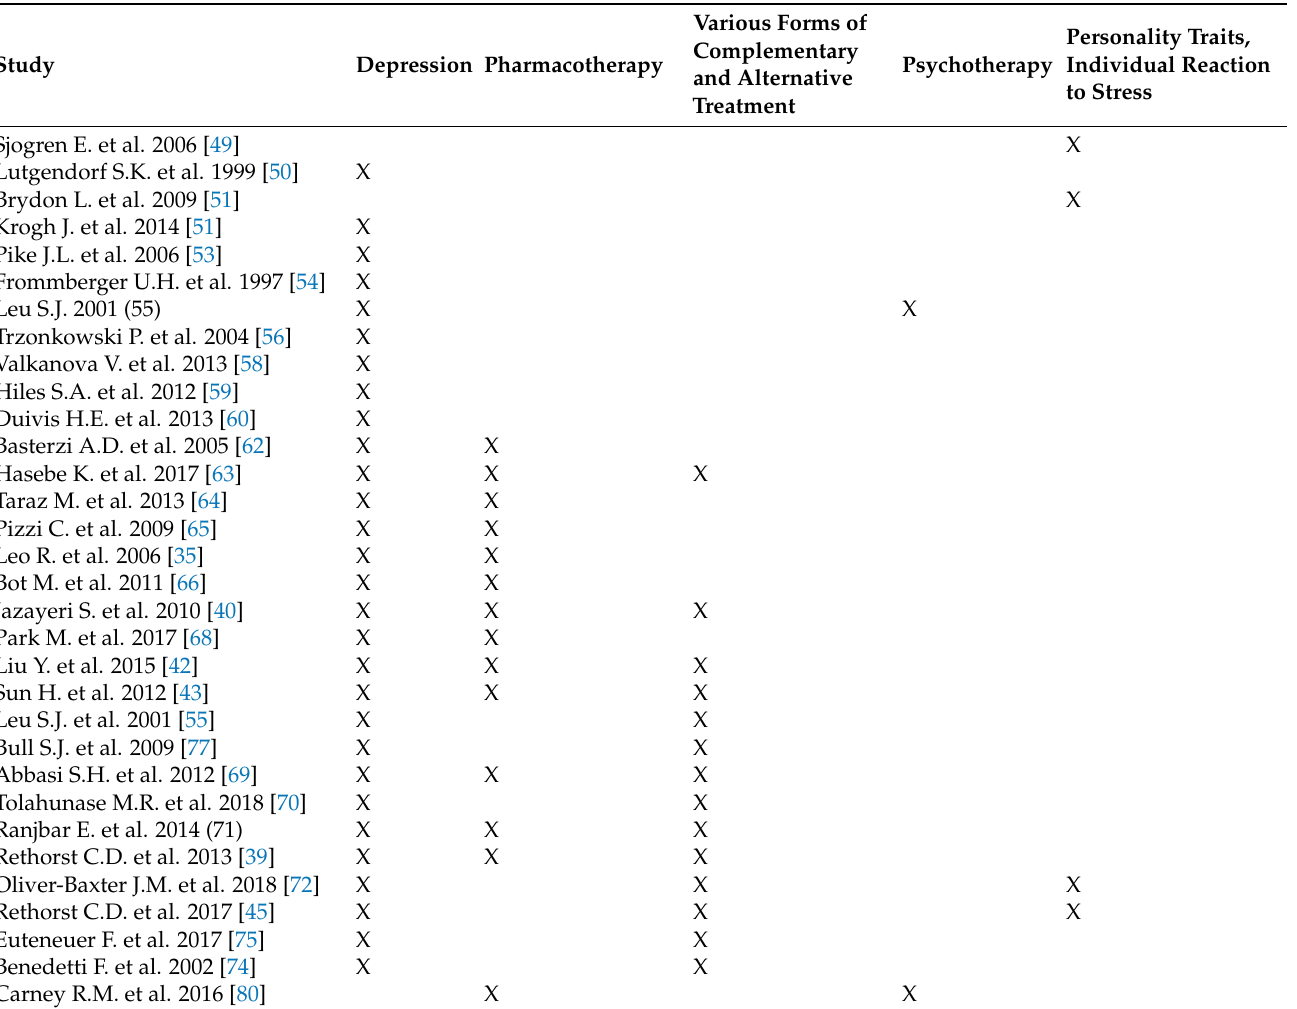
Table 3. Examples of studies on IL-6 levels with different kinds of co-factors (X marks studies focused on mentioned area). Study Depression Pharmacotherapy